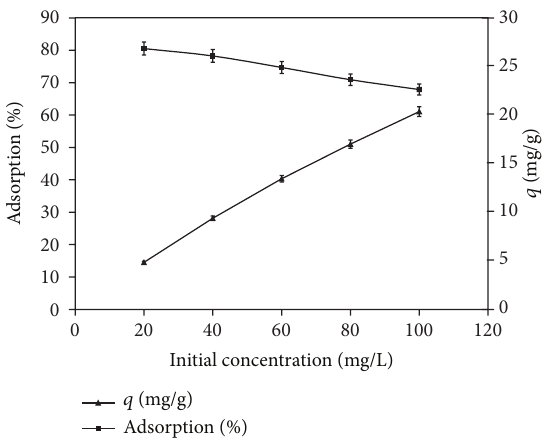
Figure 1: Effect of contact time on the biosorption of lead by Ficus benghalensis L. for 20mg/L of metal, 0.1g/30mL of biosorbent concentration, and solution pH of 6.0.